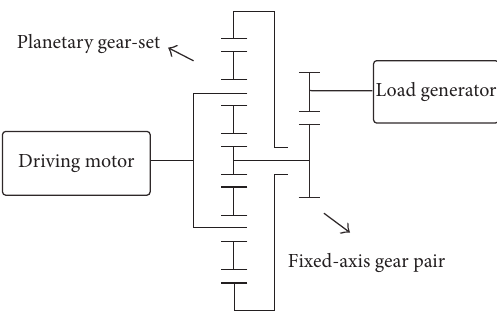
Figure 6: Schematic diagram for the simulated planetary